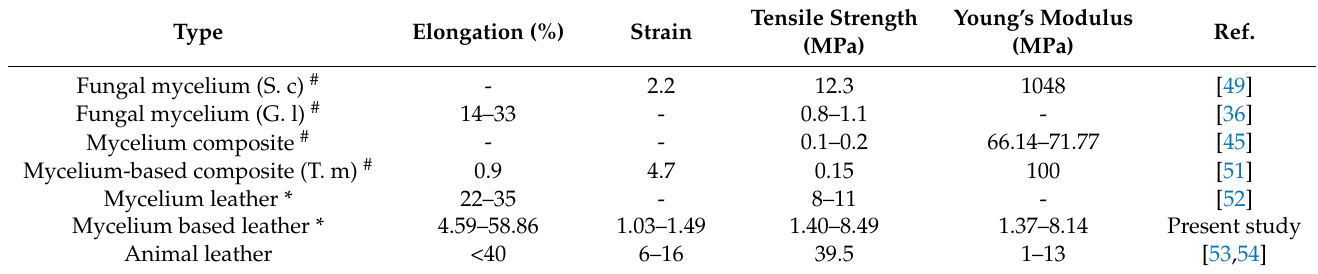
Table 3. Physical properties of mycelium-based materials and bovine leather (elongation, tensile strength, and Young’s